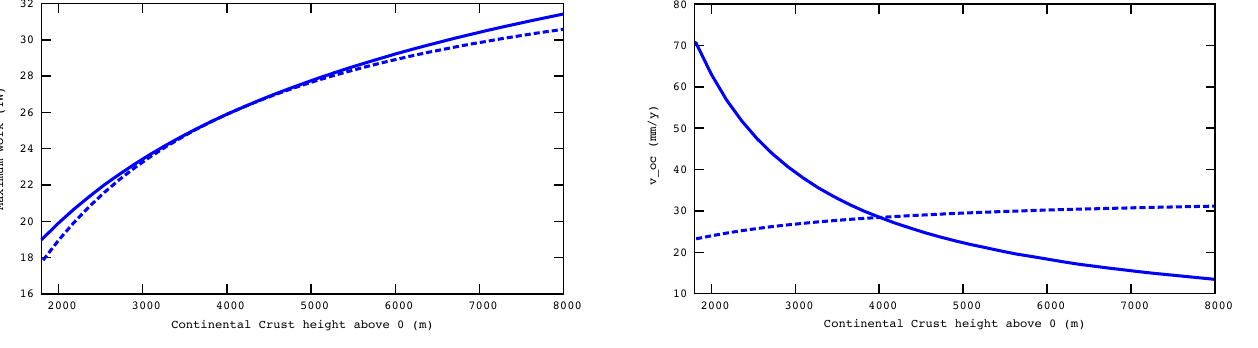
Fig. 12. Sensitivity of rates of maximum power (TW) produced in the oceanic crust system with different continental crust heights. Solutions assuming non-adaptive crust recycling are shown with a dashed line, solutions assuming adaptive crust recycling are shown with a solid line.